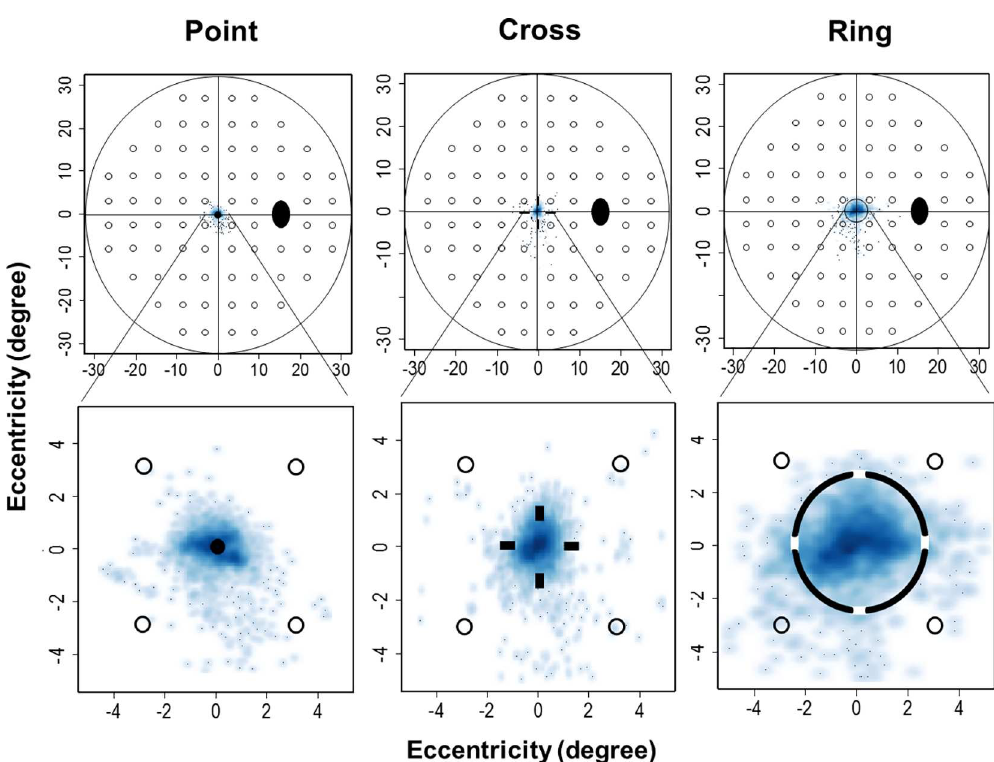
Fig 5. Typical Example of Fixation Behavior among the Three Fixation Targets. (Top) Fixation behaviorof the visual field within 30˚ and (Bottom) expandedwithin